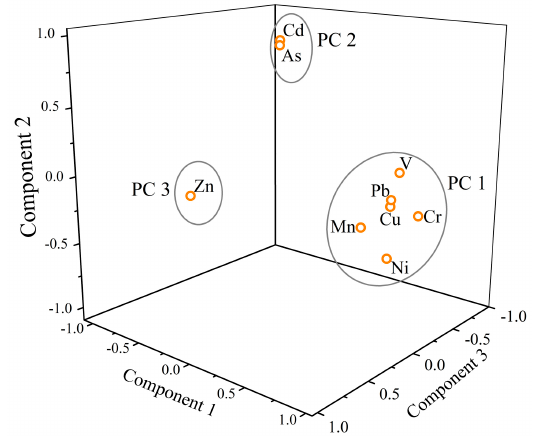
Figure 5. 3D plot of scores for heavy metal(loid)s obtained from PCA results of SPM in the Zhujiang